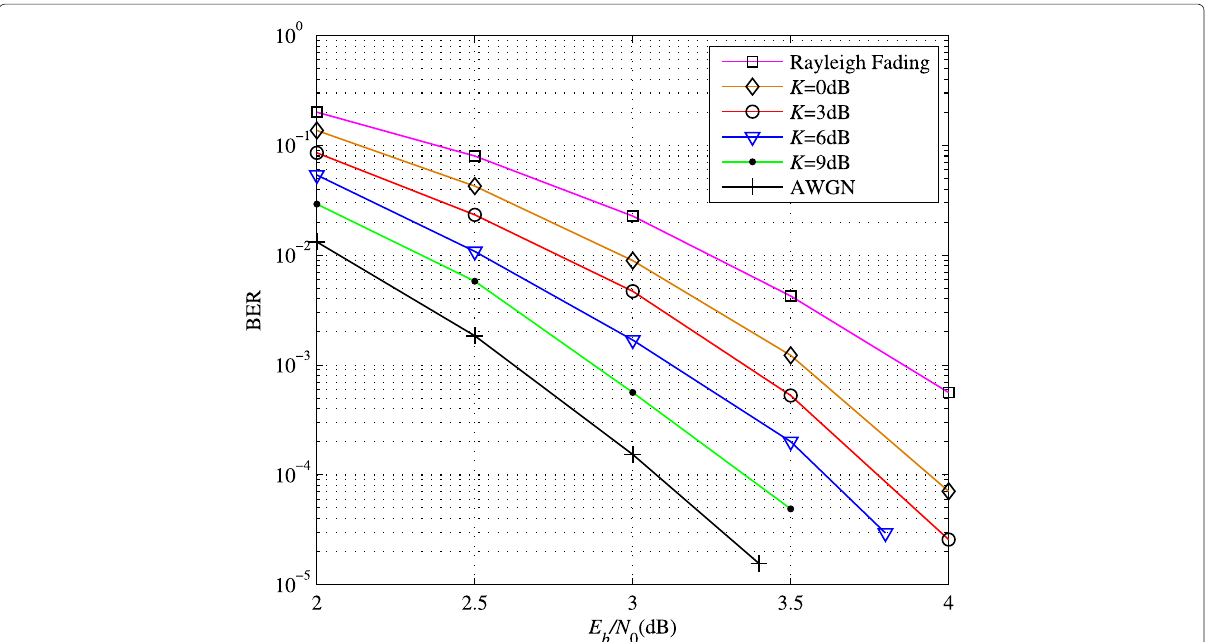
Fig. 3 BER performance of polar-coded STTD system corresponding to 2 × 1 MISO. The bit error rate performance of polar-coded STTD system with two transmit antennas and one receive antenna. The Rician K -factors are various, which include the positive infinity (AWGN) and negative infinity